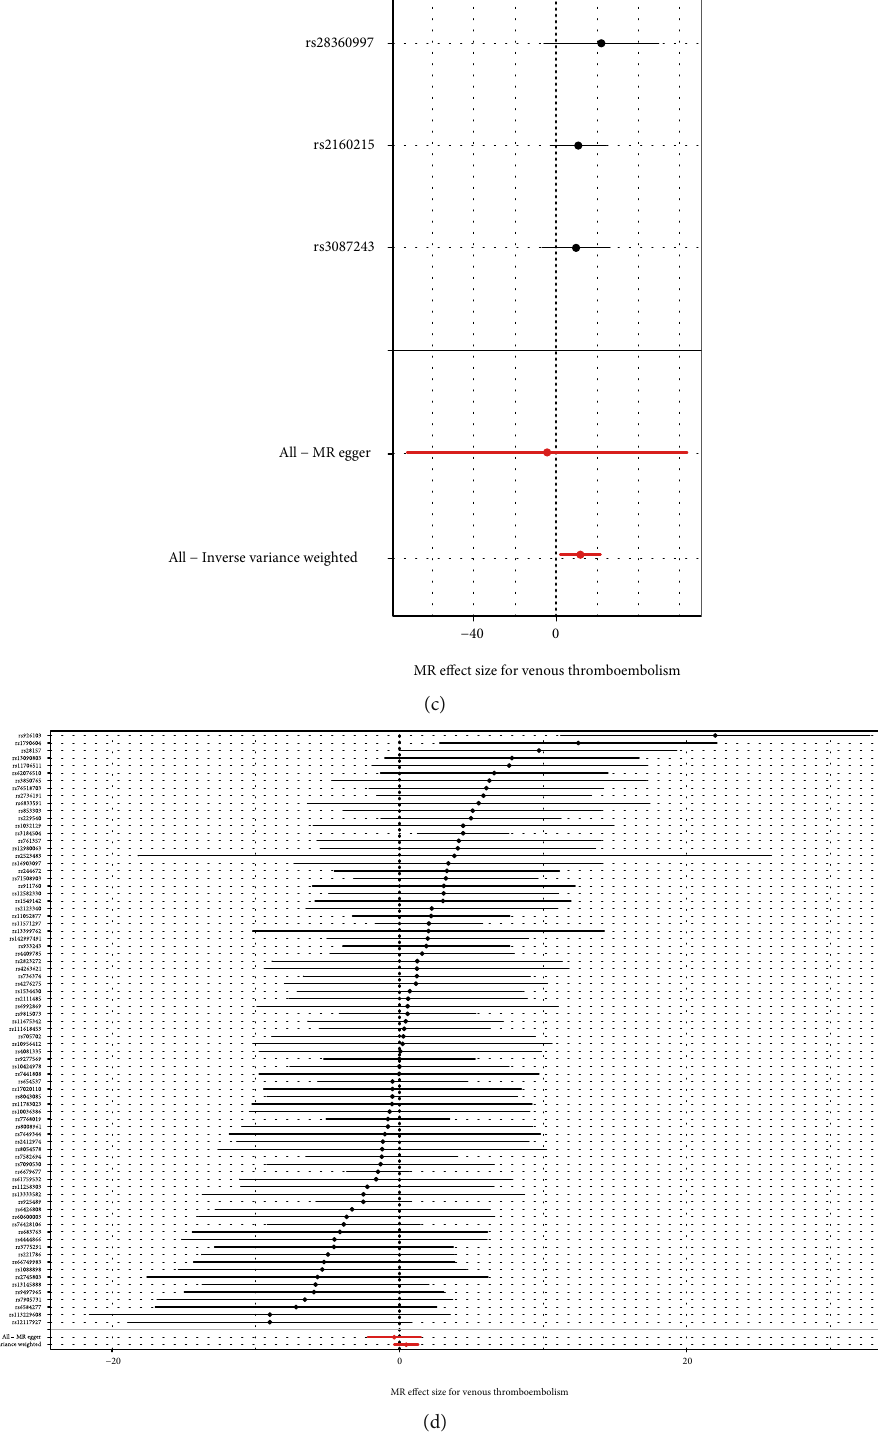
Figure 1: Forest plots for the association of FSH-, TSH-, hyperthyroidism-, and hypothyroidism-associated SNPs with risk of venous thromboembolism. (a) FSH, (b) TSH, (c) hyperthyroidism, and (d) hypothyroidism. In the forest plots, black points represent the log OR for venous thromboembolism per SD increase in FSH, produced using each FSH-associated SNP as an IV. Red points represent the combined causal estimates using all SNPs as an IV on the basis of MR-Egger and IVW methods. Horizontal line represents 95% CI of the estimates. Abbreviations: SNP: single nucleotide polymorphism; TSH: thyrotropin; OR: odds ratio; CI: con fi dence